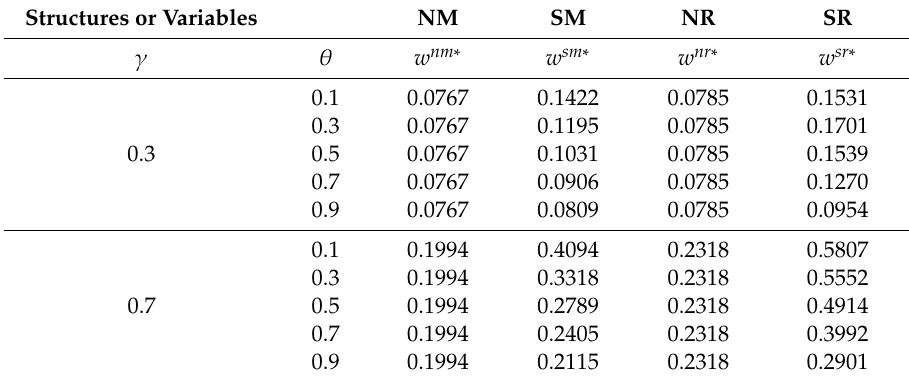
Table 3. The influence of sharing ratios on the wholesale price under four modes (Unit: